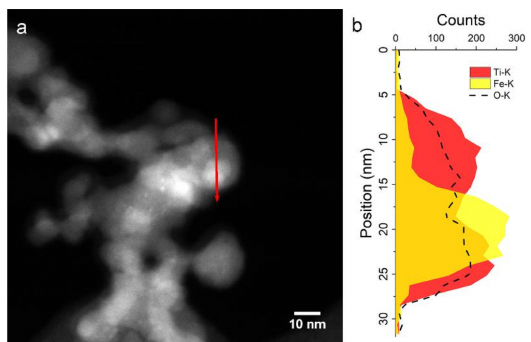
Figure 10. Fe/TiO x sample after 4 h in 1 MPa H 2 at 400 ◦ C. ( a ) STEM image; ( b ) EDX line profile acquired along the red arrow, highlighting a Fe NP among TiO x NPs.